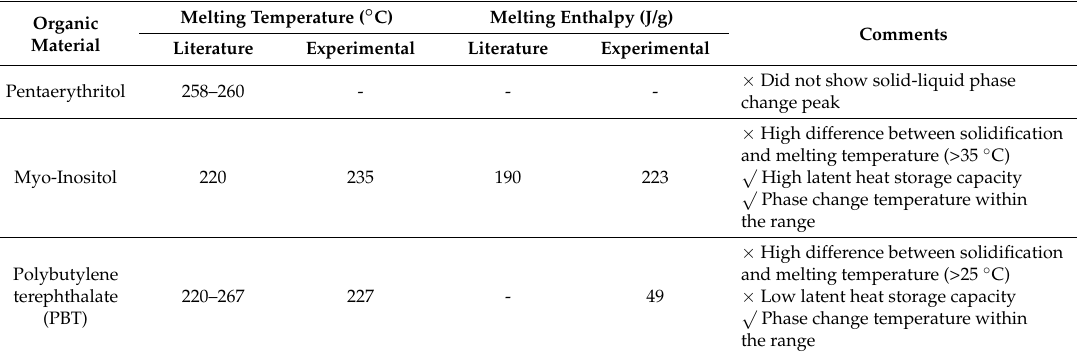
Table 8. DSC results of organic materials (polymer and sugar alcohol)